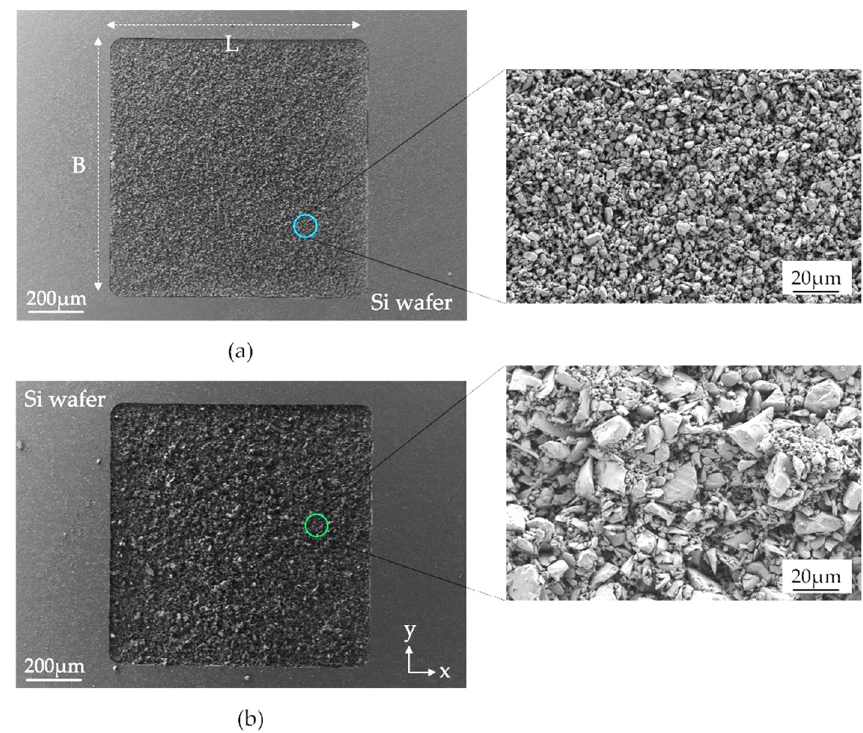
Figure 3. SEM images of top view of the surface of the ALD agglomerated micromagnets. Note that the particles shown in the images are already solidified by an Al 2 O 3 -ALD layer. ( a ) NdFeB5 (d50 = 5 µ m) and ( b ) NdFeB25 (d50 = 25 µ m). The detailed micrographs on the right side depict the granular structure of the